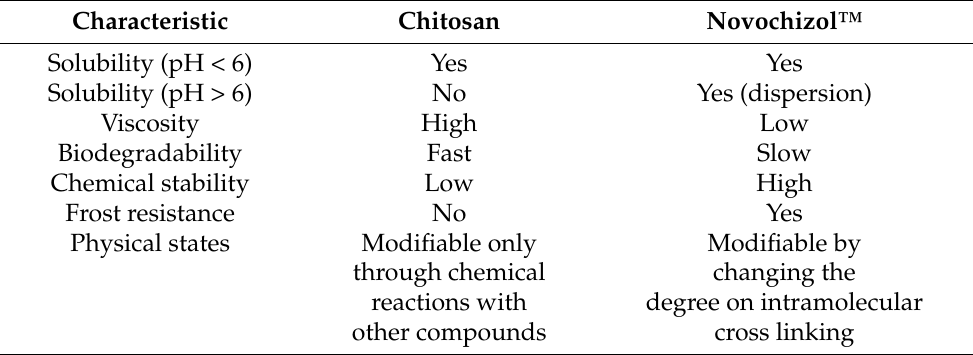
Table 1. Characteristics of Novochizol™ of importance in plant treatment, in comparison with chitosan.